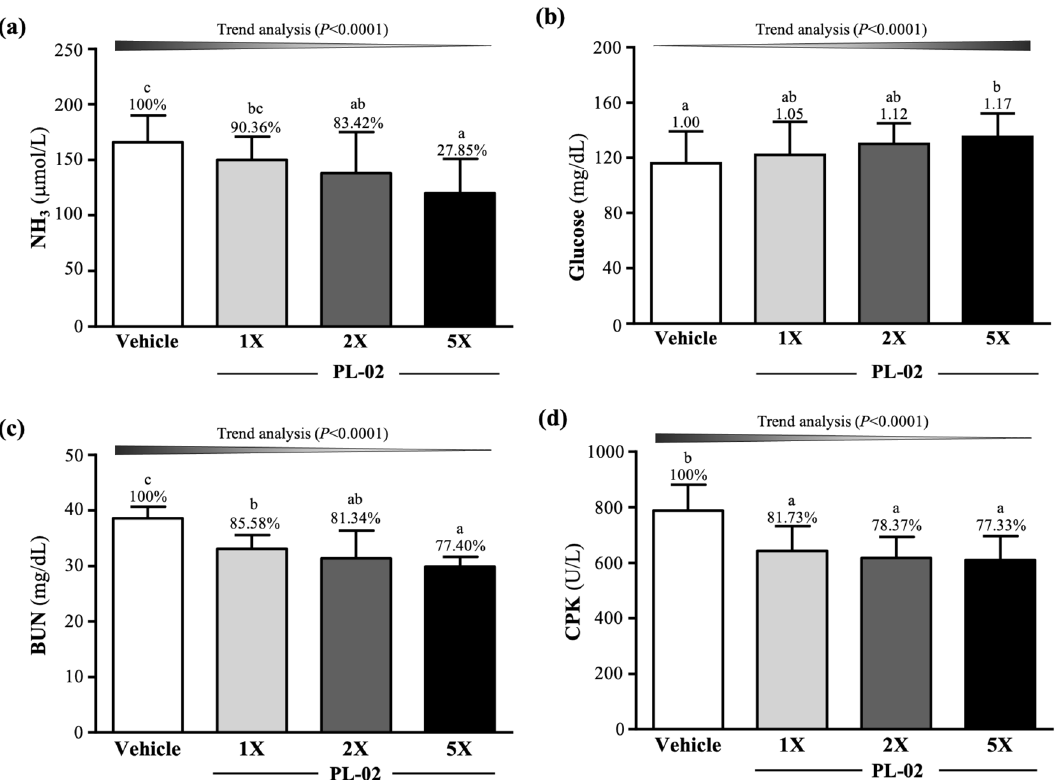
Figure 2. Effect of 4 weeks PL-02 supplementation on ( a ) NH 3 and ( b ) glucose, ( c ) BUN and ( d ) CK. Data are expressed as mean ± SD for n = 10 mice per group. Different superscript letters (a, b, c) indicate significant difference at p <